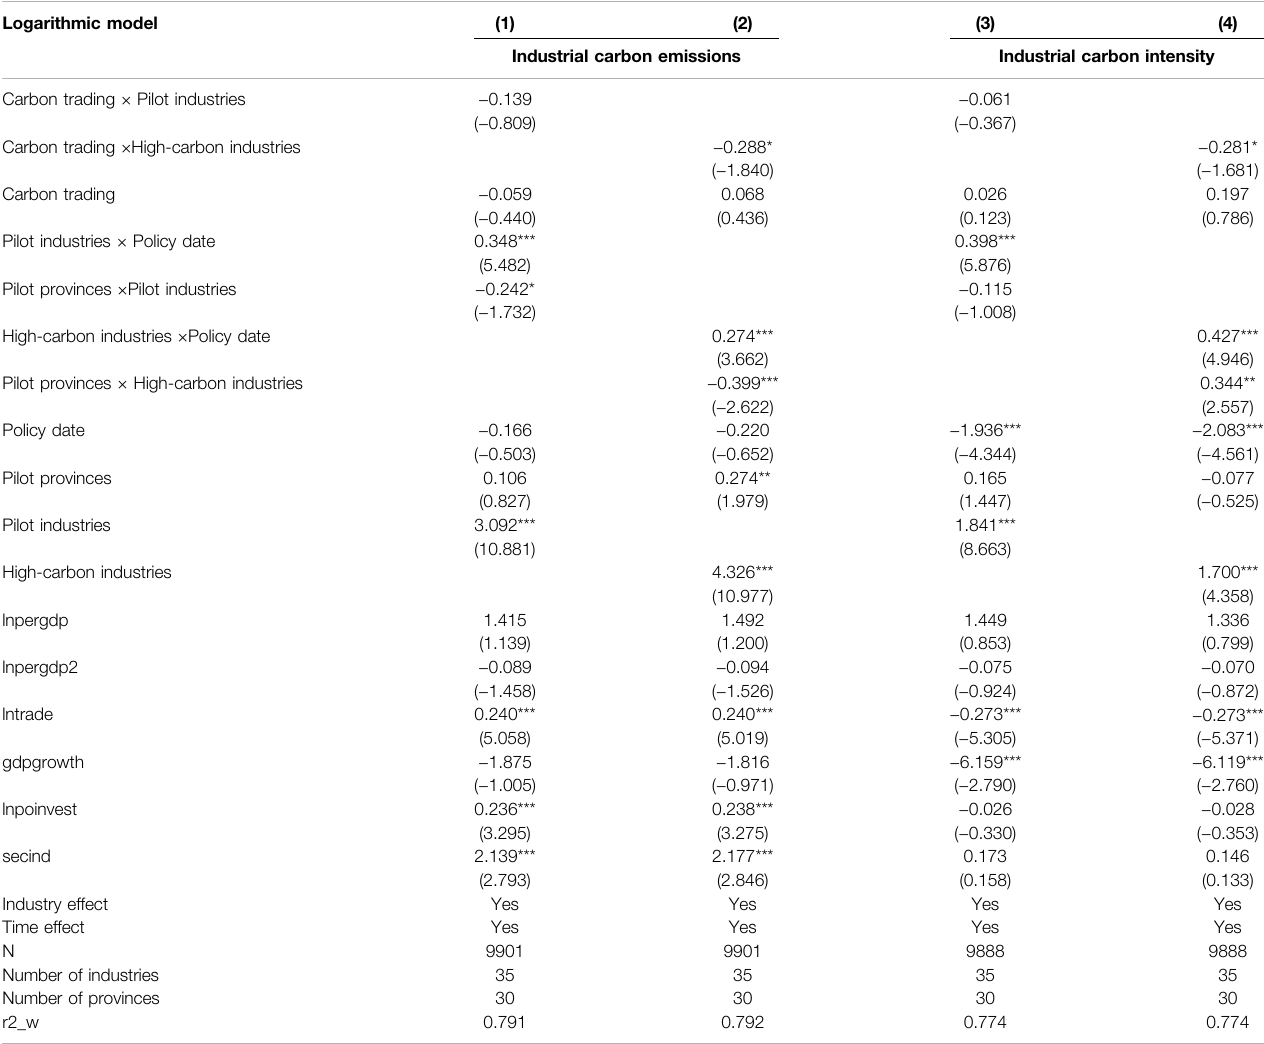
TABLE 6 | DDD analysis of the impact of carbon trading on regional industrial carbon emissions. Logarithmic